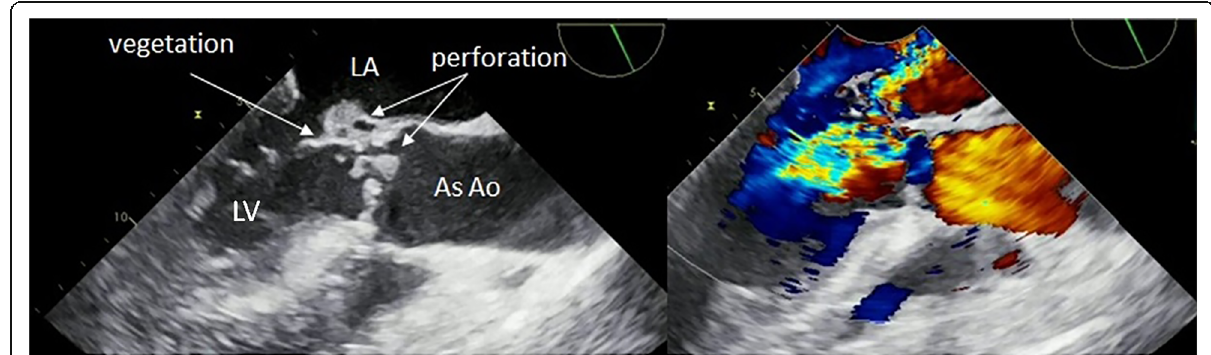
Fig. 1 Three-chamber transoesophageal echocardiographic view reveals vegetation (size, 25 × 15 mm) attached to the anterior leaflet of the mitral valve. Color flow imaging reveals severe insufficiency of both the aortic and mitral valves with perforation in the AMC and at the base of